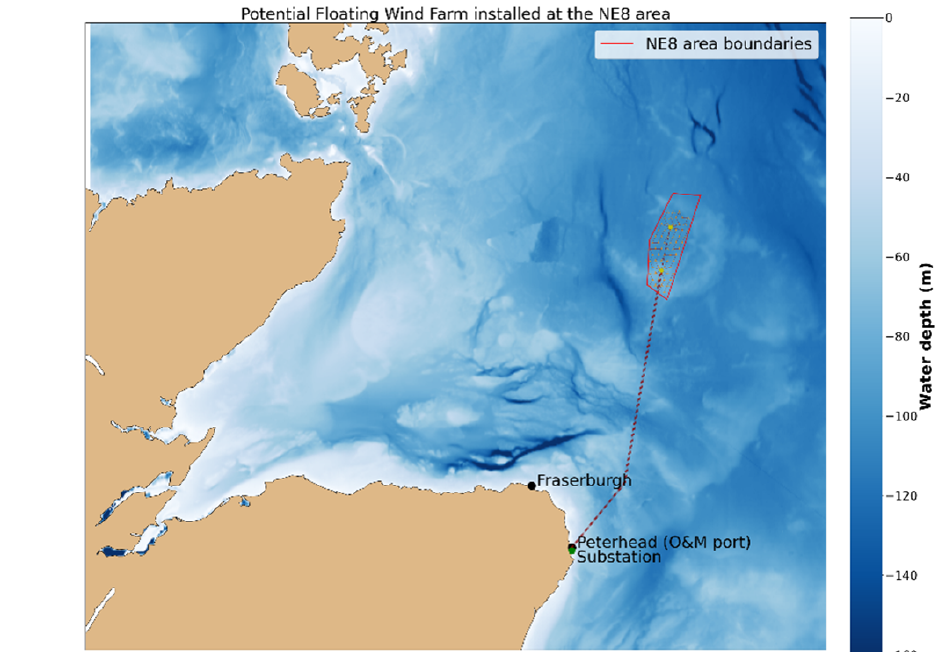
Figure 2. Hypothetical floating wind farm layout.